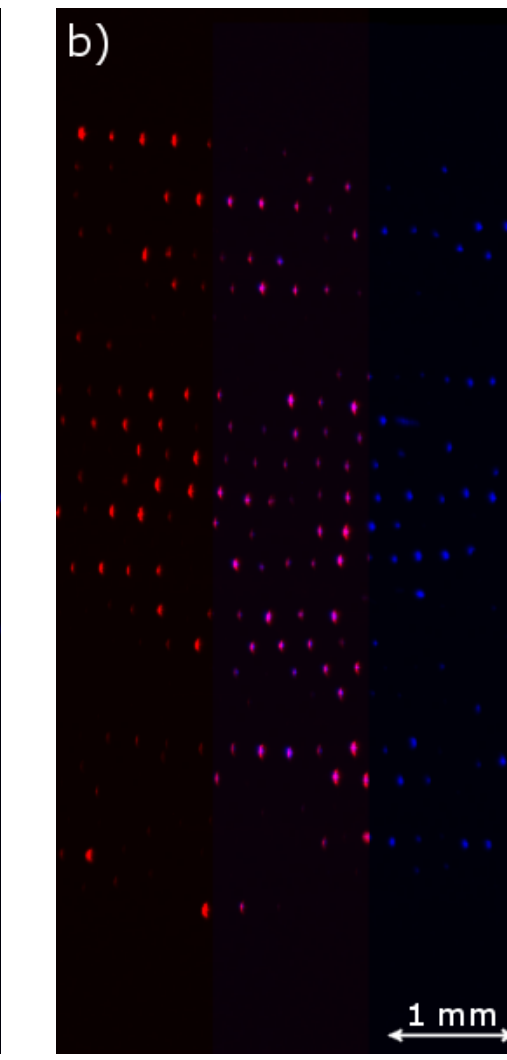
Figure 8. RGB pictures of the region around the overlap. The image from Camera 1 is contained in the red channel, that (after transformation) from Camera 2 in the blue channel. Accordingly, on the left side, only red particles are visible, and, on the right, only blue ones. In the overlap region, the two channels mix, resulting in magenta pixels if both channels contain data. The right image in ( a ) was transformed with Method I (mutual information), that in ( b ) with Method II (particle positions). The left image is identical in ( a , b